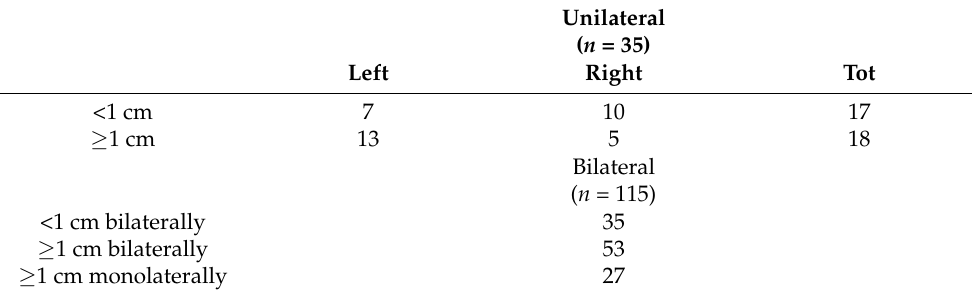
Table 2. Characteristics of PE.